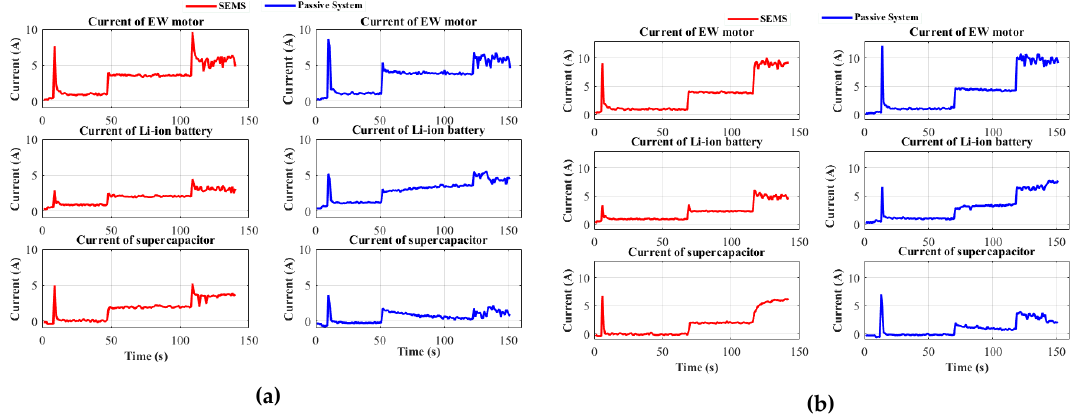
Figure 16. Comparison of the proposed SA-HESS and P-HESS during different loads: ( a ) 35-W load; ( b ) 25-W load.